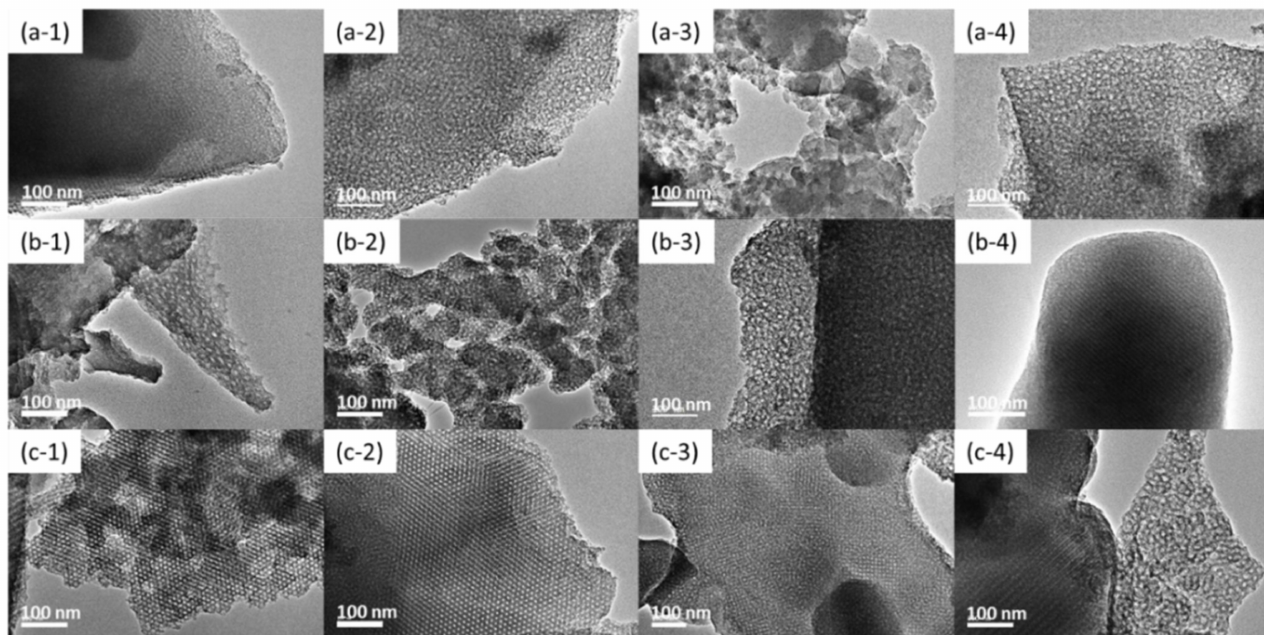
Figure 3. TEM images of mesoporous organosilica samples: PMOFH-1 ( a-1 ), PMOFH-2 ( a-2 ), PMOFH-3 ( a-3 ), PMOFH-4 ( a-4 ), PMOAH-1 ( b-1 ), PMOAH-2 ( b-2 ), PMOAH-3 ( b-3 ), PMOAH-4 ( b-4 ), PMOBH-1 ( c-1 ), PMOBH-2 ( c-2 ), PMOBH-3 ( c-3 ), PMOBH-4 ( c-4